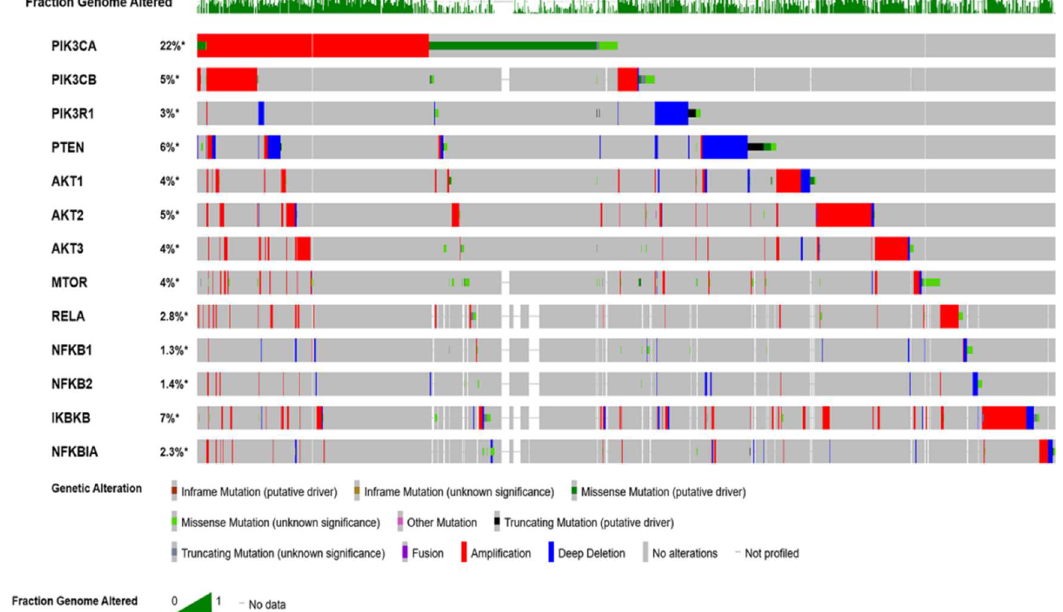
Figure 1. Oncoprint mutation profile of ovarian cancer data curated from The Cancer Genome Atlas (TCGA) datasets. Profile was generated from datasets in cBioPortal (http://www.cbioportal.org) for Cancer Genomics.